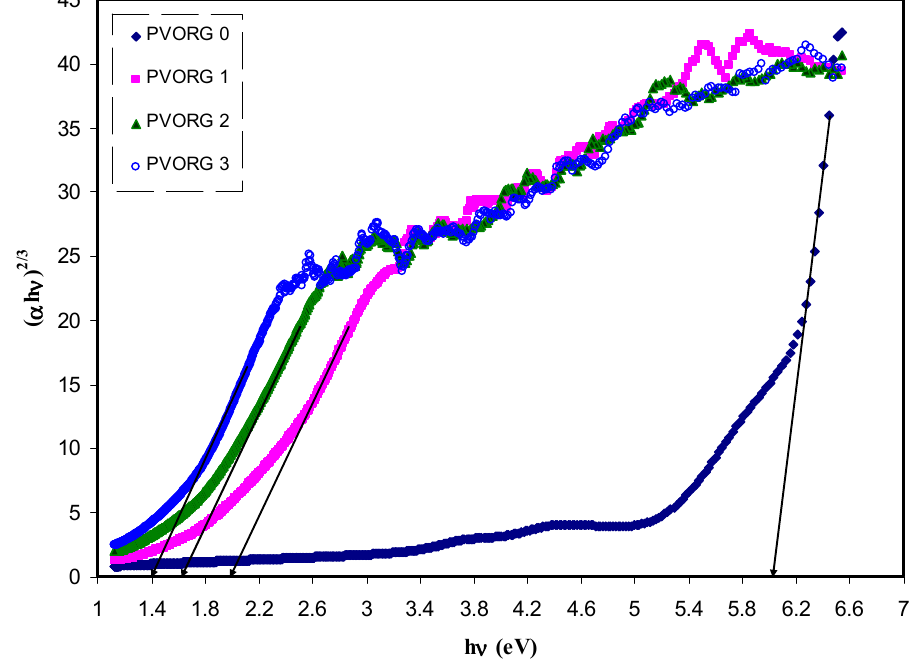
Figure 13. Plot of ( α h υ ) 2 / 3 vs. photon energy for pure PVA (PVORG0) and PVA composite films.